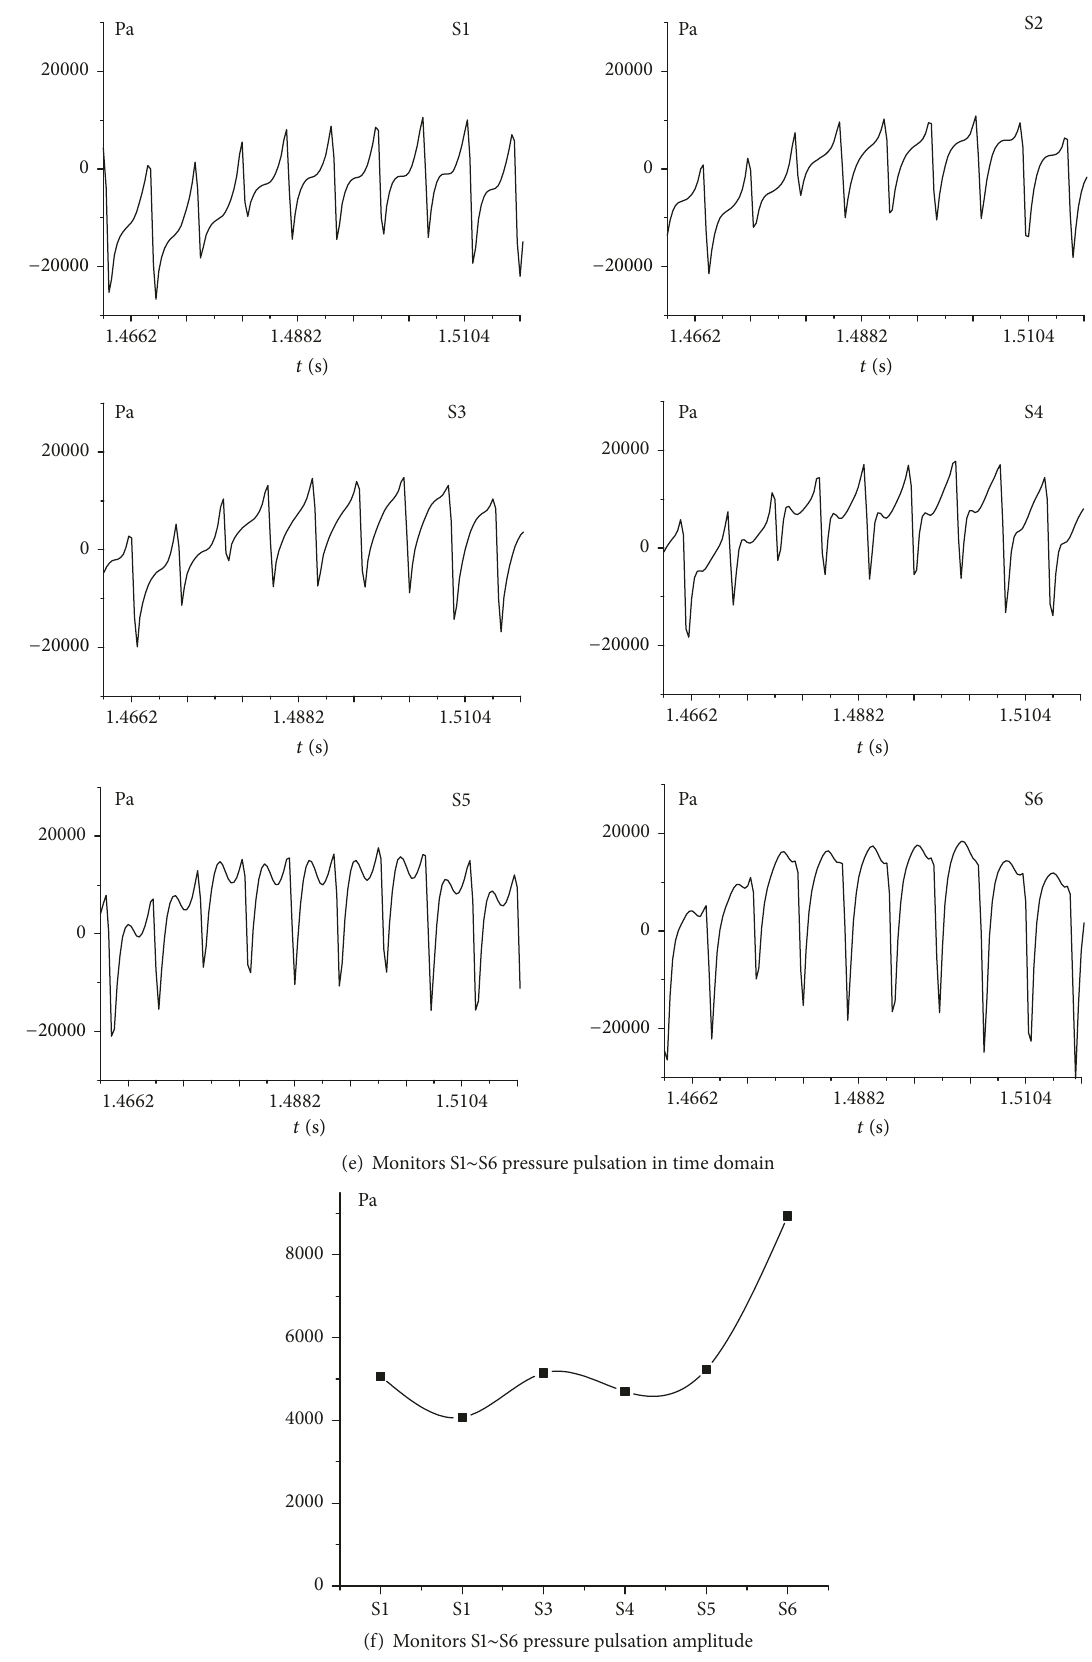
Figure 7: Pressure pulsation of all